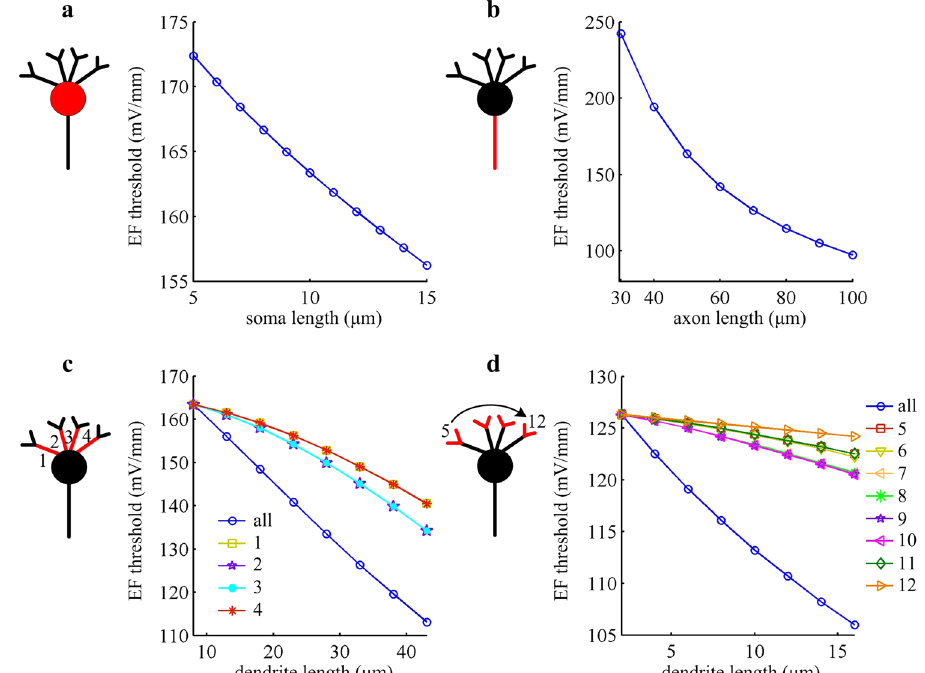
Figure 3. EF firing threshold negatively correlates with compartment length in artificial model. EF threshold for triggering APs is respectively showed as a function of the compartment length of (a) soma, (b) axon, (c) proximal dendrites, and (d) distal dendrites. The diameter of relevant compartment takes the initial